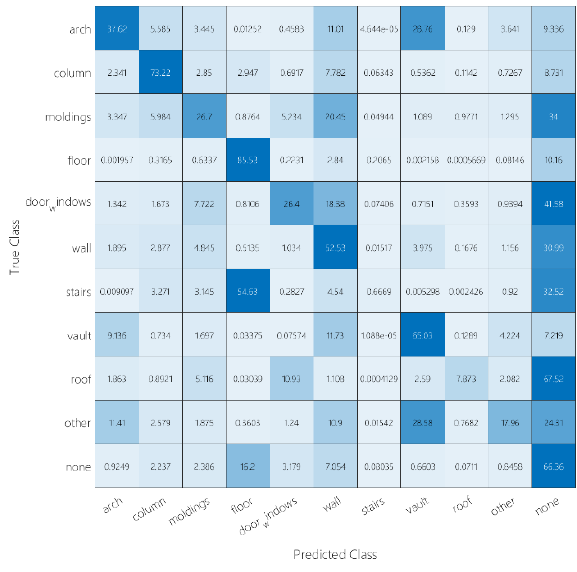
Figure 6: Confusion Matrix for Test